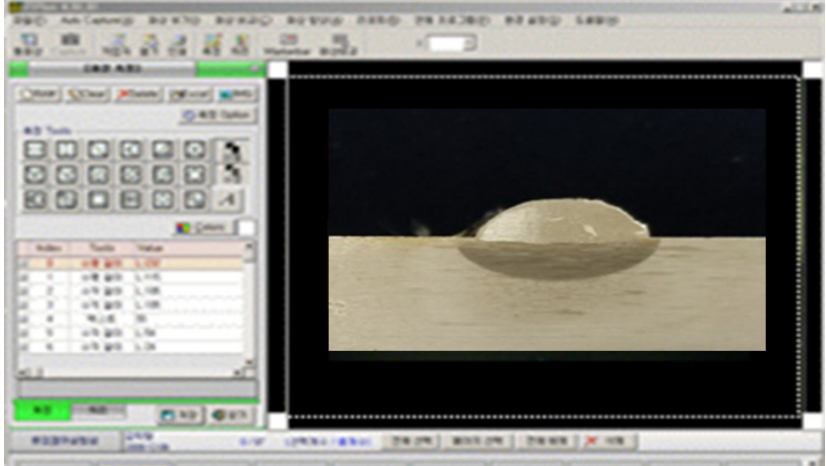
Figure 5. Schematic diagram of dilution ratio.